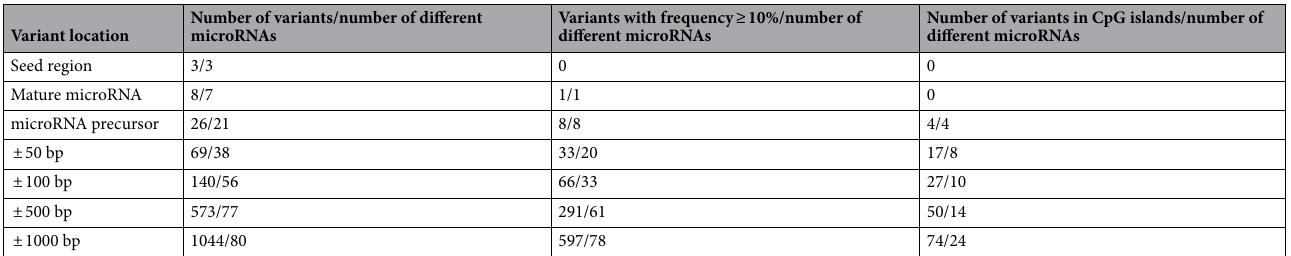
Table 2. Number of detected bovine microRNA genetic variants of interest, according to their locations. The number of microRNAs presenting at least 1 variant was mentioned, as well as the number of variants with a frequency ≥ 0.10 and those located in CpG